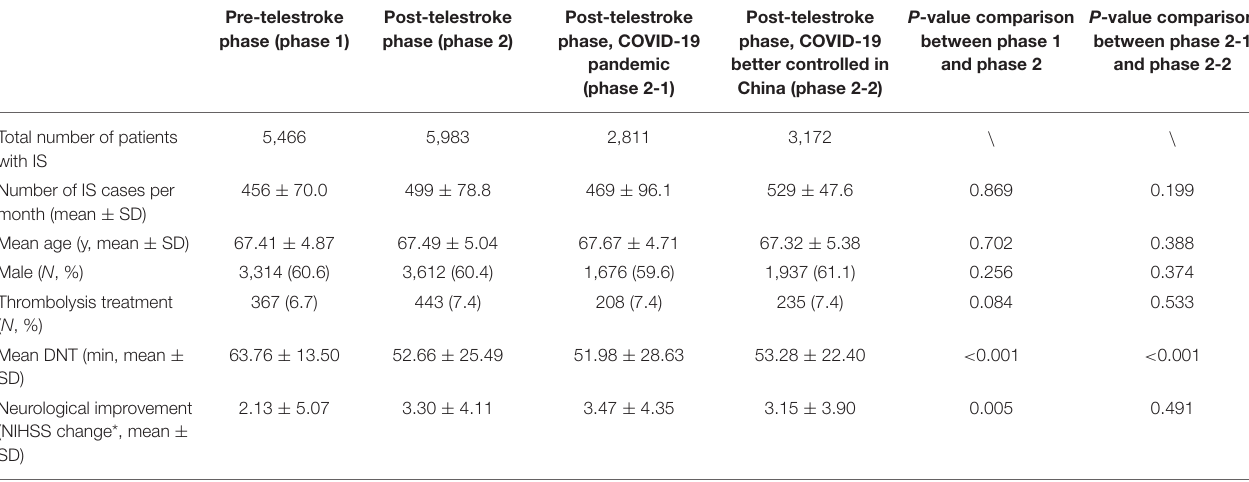
TABLE 1 | Characteristics of patients with ischemic stroke (IS) and those receiving intravenous